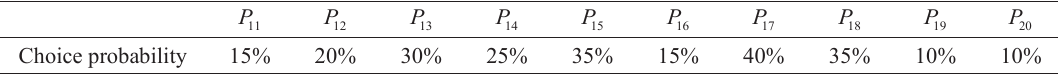
Table 12. Customer selection probabilities of 20 alternative product variants